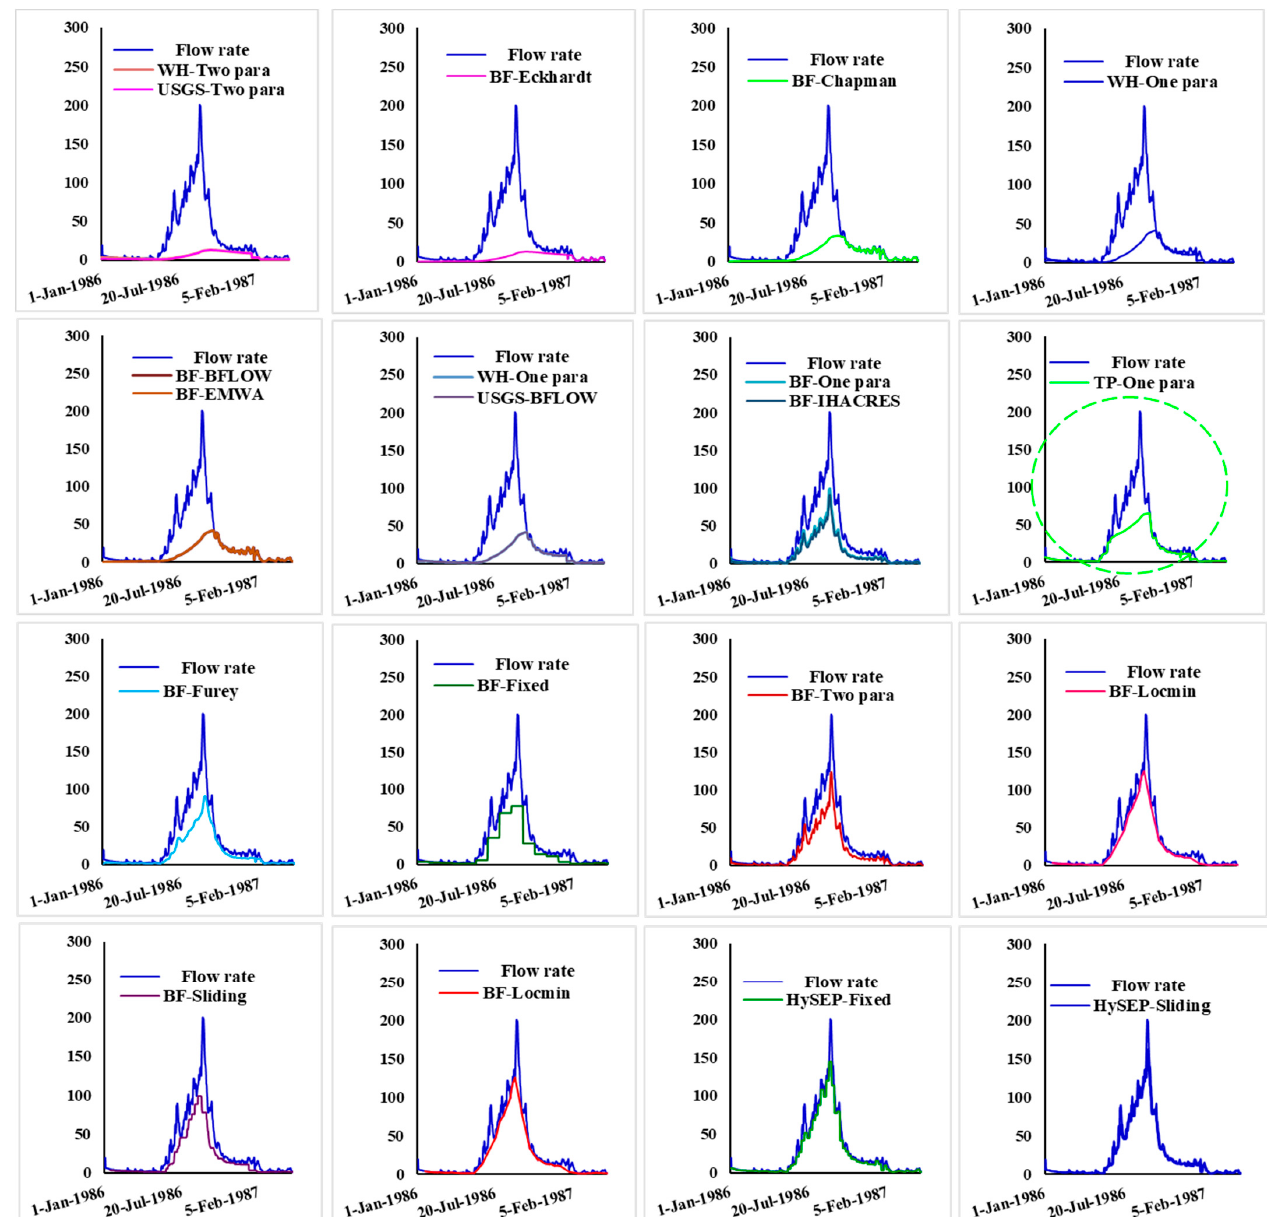
Figure 14. Baseflow separation (one-year) results using each automated RDF method for the Sor stream.